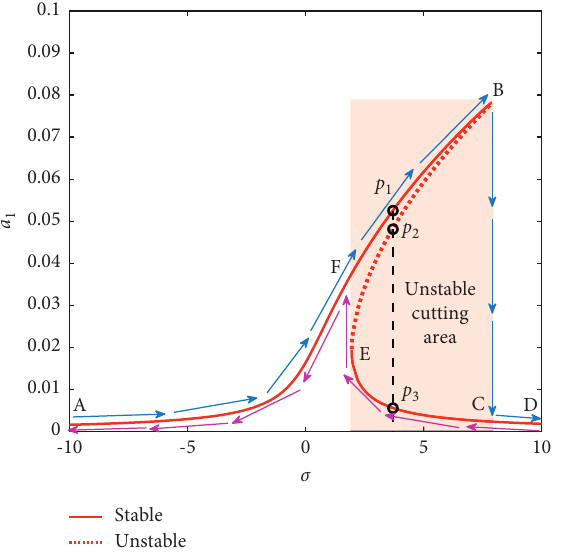
Figure 4: Frequency response curve in case I. Figure 5: The effect of ratio of length to diameter on frequency response curve ( c � 0.01, θ � 0 ° , case I).